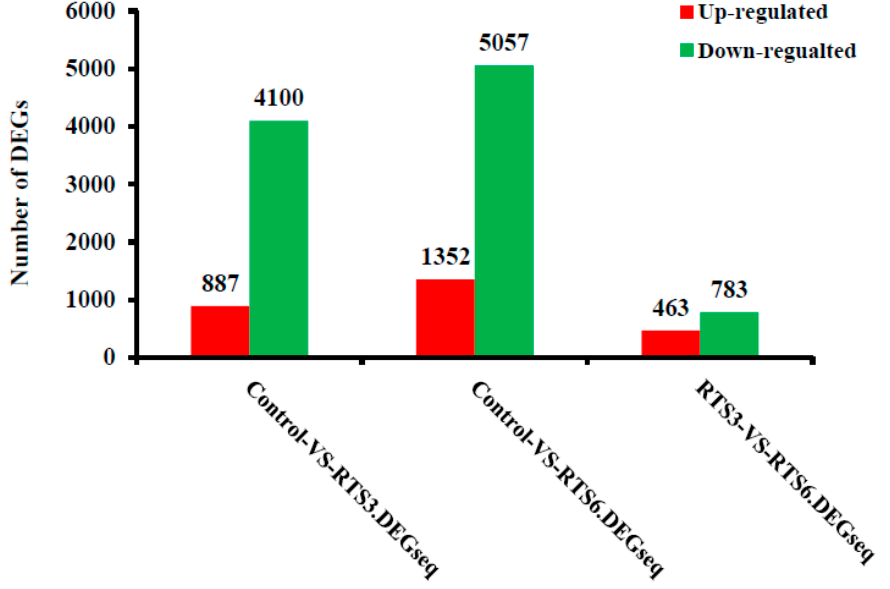
Figure 5. Numbers of regulated genes in browning pericarp. Red columns represent the numbers of upregulated genes, and green columns represent the numbers of downregulated genes.